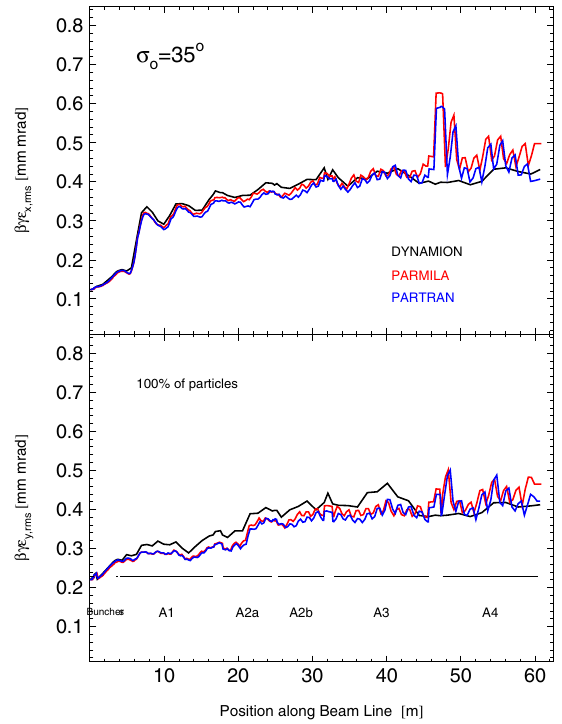
FIG. 14. (Color) Transverse normalized 100% rms emittances along the beam line as simulated by the three codes for a transverse zero current phase advance (cid:4) o of 35 (cid:1) .